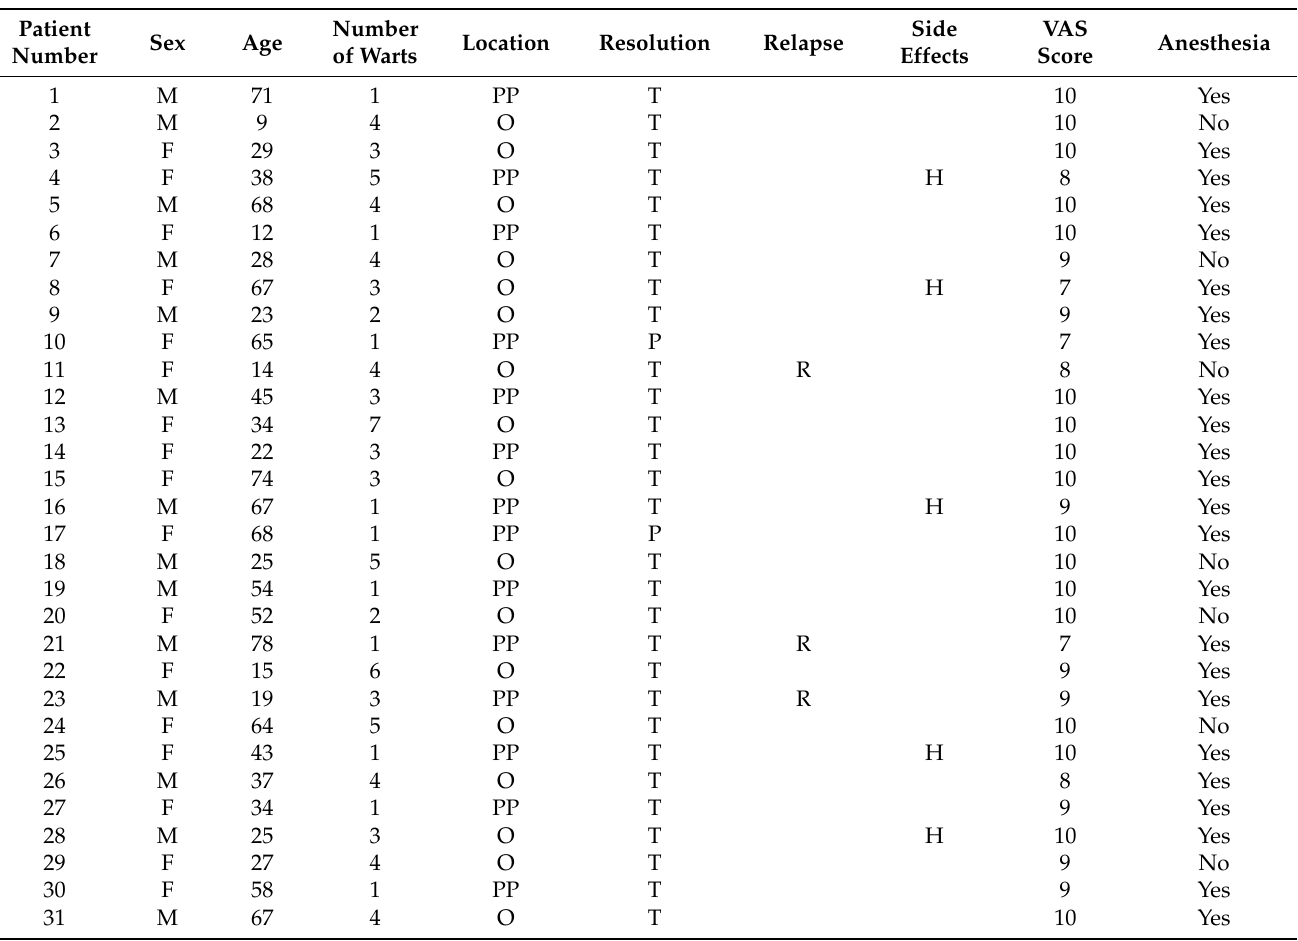
Figure 1. Patient n. 3 before treatment ( left ), during laser therapy ( central ), and 4 months after treatment ( right ). Table 2. Treatment protocol. Table 1. Patient